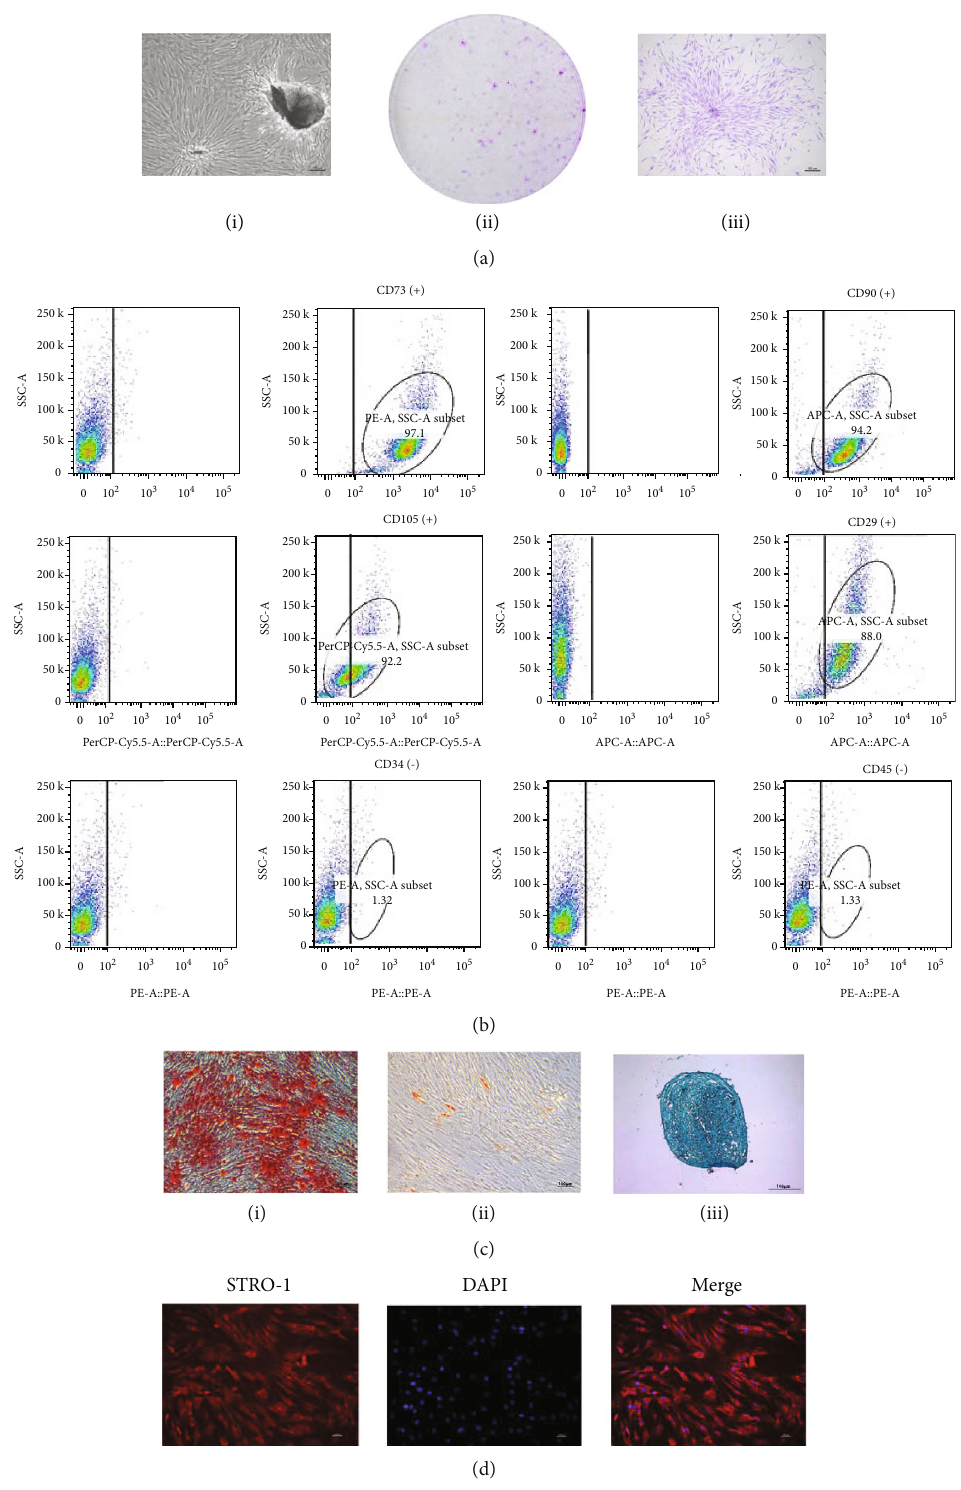
Figure 1: Identi fi cation of PDLSCs and veri fi cation of PDLSC multidirectional di ff erentiation ability. (a): (I) Primary cells migrated from PDL tissues on day 3, and 80% con fl uence was observed on day 12 (scale bar: 100 μ m). (II, III) Cell colonies formed by PDLSCs observed in the dish and an ampli fi ed image of a representative colony captured by a microscope (scale bar: 100 μ m). (b) Flow cytometry results showed that CD29, CD73, CD90, and CD105 were positive in PDLSCs. In addition, both CD45 and CD34 were negative. (c) Multiple di ff erentiation potentials of PDLSCs (from left to right: osteogenesis, adipogenesis, chondrogenesis; scale bar: 100 μ m). (d) Immuno fl uorescence assay revealed that cultured PDLSCs were positive for STRO-1 (scale bar: 100 μ